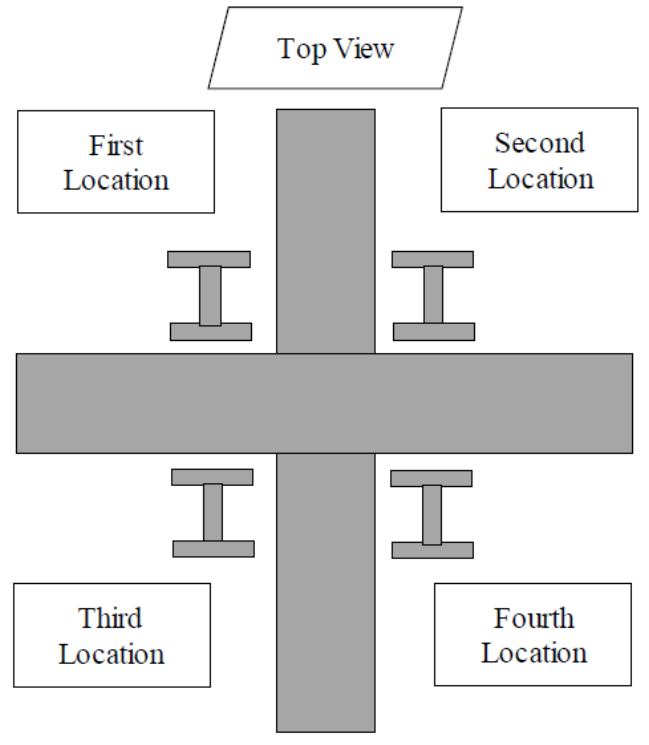
Figure 6. A picture of the kingpost location.